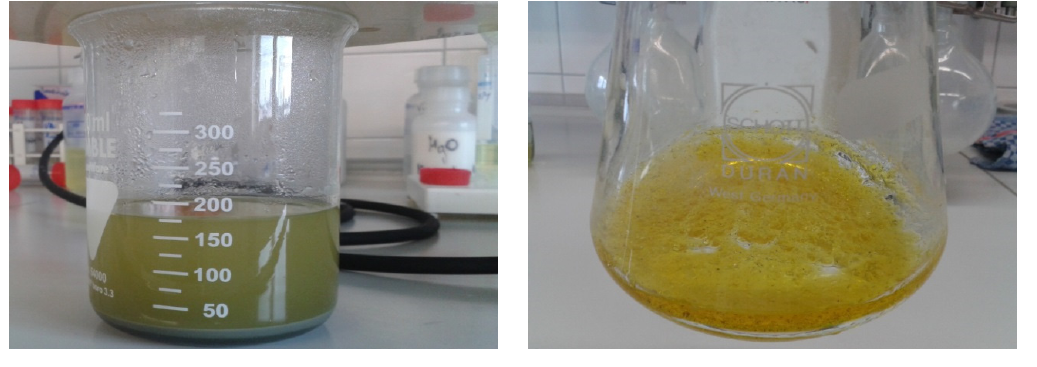
Figure 4. Experiment 2 and Experiment 3.